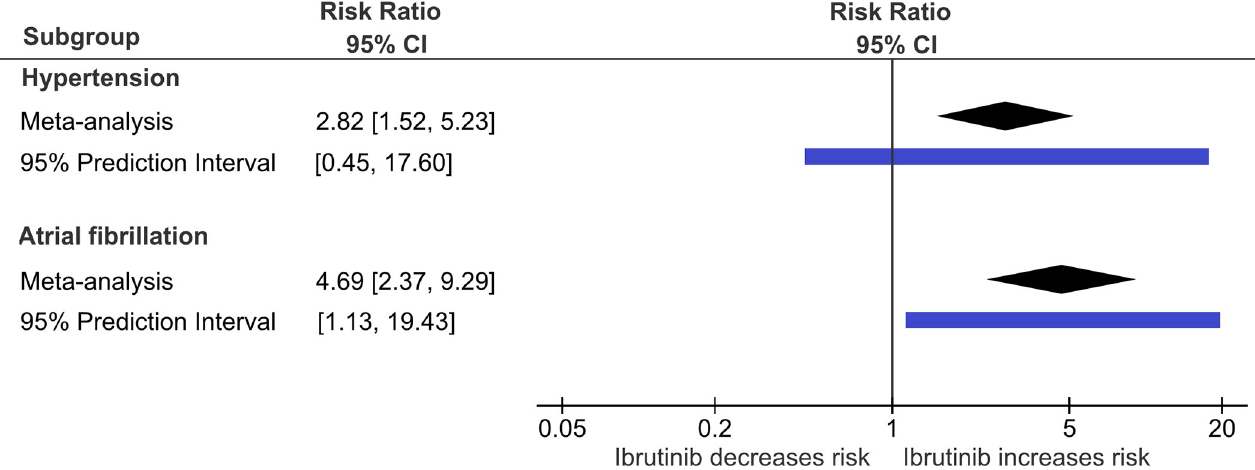
Fig 4. Risks of hypertension and atrial fibrillation associated with ibrutinib from meta-analysis (black diamond) and 95% predictive intervals (blue rectangle).